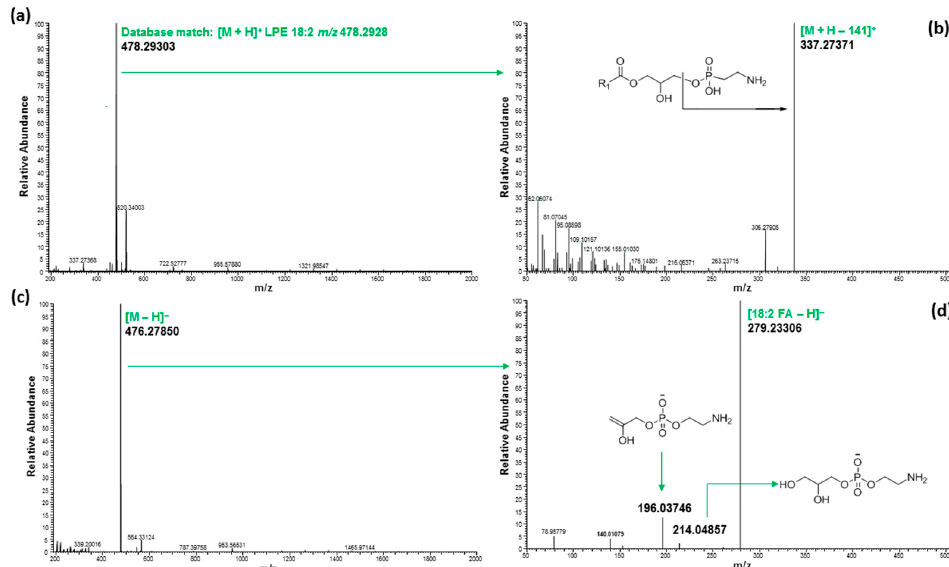
Figure 9. Mass spectrum of LPE eluted at 3.95 min with molecular ion at m / z 478.29303 in positive mode ( a ), fragmentation of LPC with molecular ion at m / z 478.29303 ( b ), mass spectrum of LPE eluted at 3.95 min with molecular ion at m / z 476.27850 in negative mode ( c ), fragmentation of LPC with molecular ion at m / z 476.27850 ( d ).